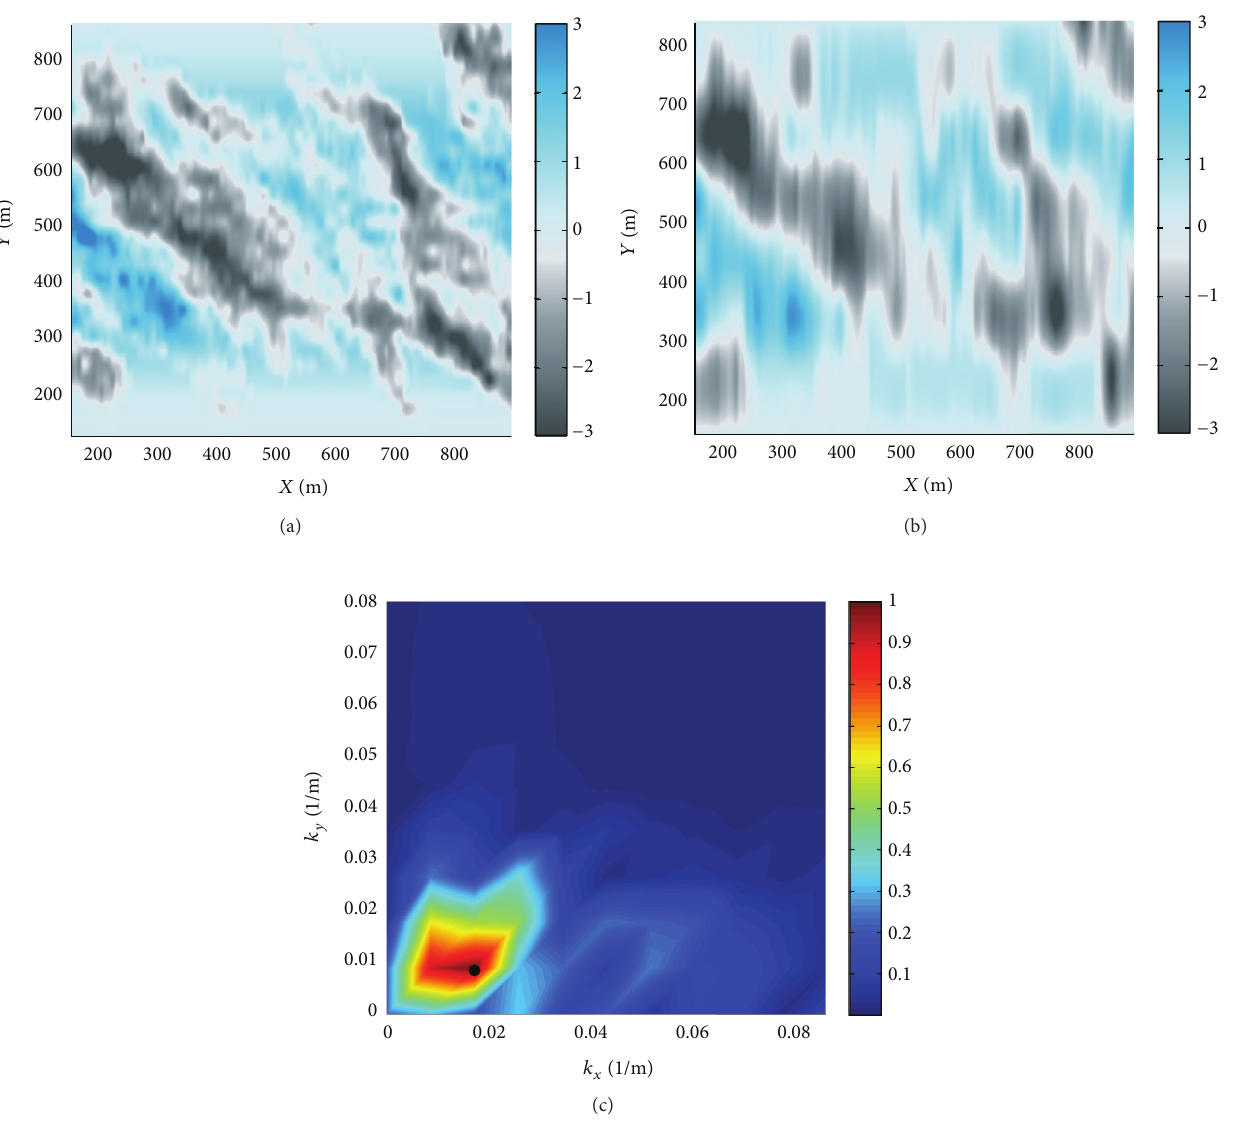
Figure 5: Streamerwise imaged sea surface as shown in Figure 4, but now the spacings between the streamers are, respectively, (a) 25 m, (b) 100m, and (c) the ensemble averaged spectrum of the imaged sea surface in case of 100m spacing. The indicated peak of the spectrum corresponds to 𝐾 𝑥 = 0.01704 and 𝐾 𝑦 = 0.00852